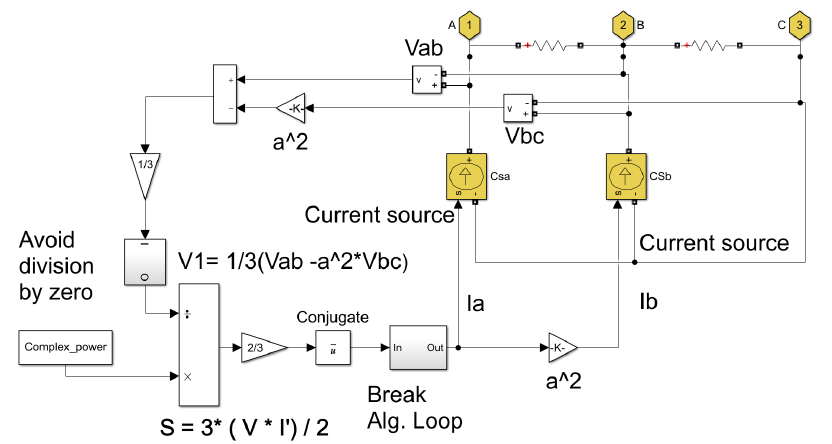
Figure 6. Implementation of IBFPR with ideal current sources and voltage monitoring in the extended IEEE model [29].